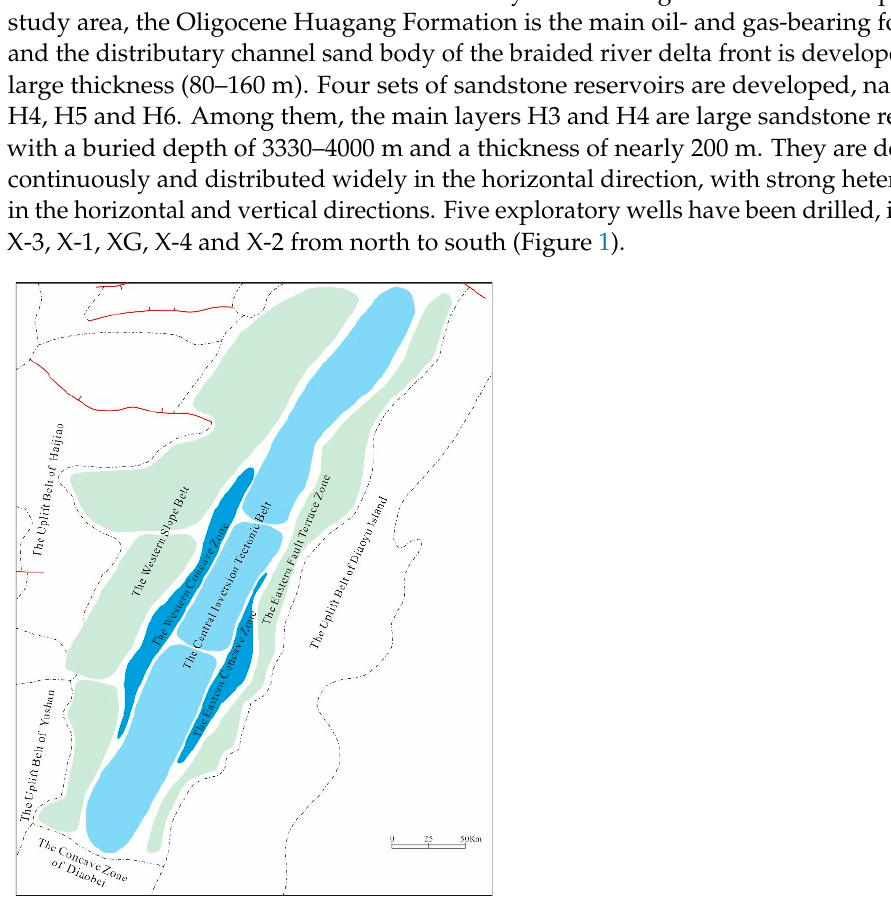
Figure 1. Location map of the north-central part of the central inversion structural belt in the Xihu Depression.